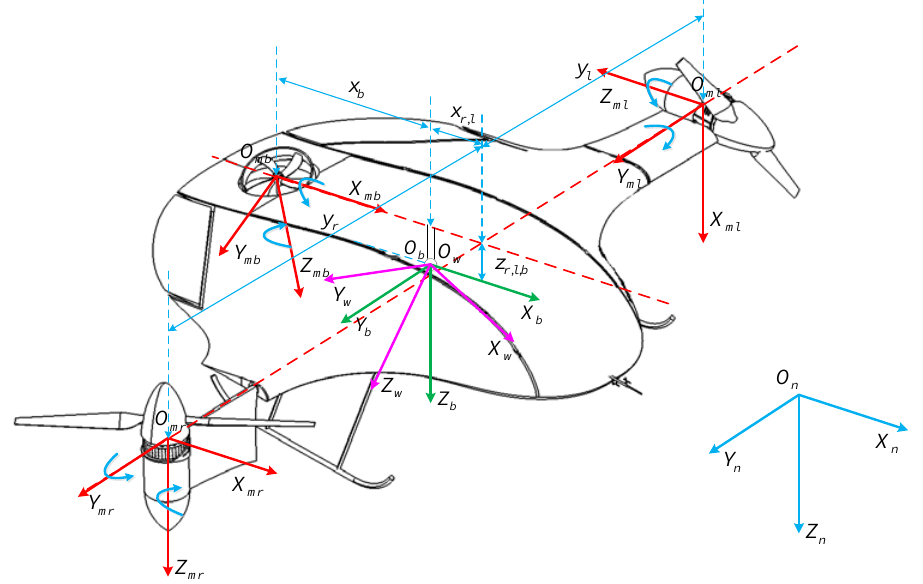
Figure 3. The structure of the BWTR UAV. The model parameters of the tilt-rotor UAV are specified in Table 1.